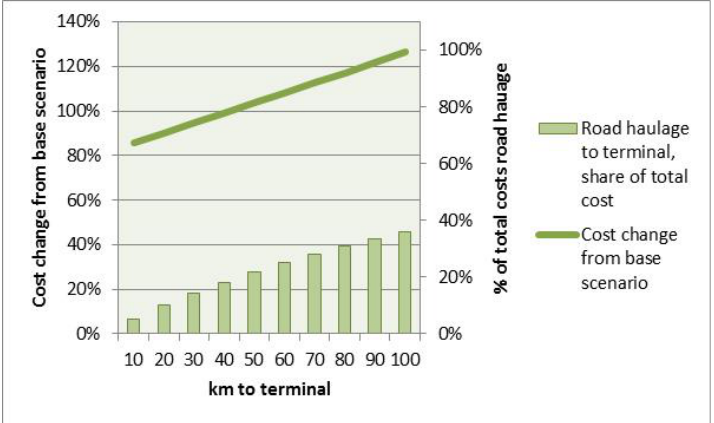
Figure 16. Effect of changed road distance to terminal with intermodal transhipment for the base scenario. Similar results are found for the 40m 3 system with an increased number of wagons, at a 1% cost increase. See Figure 17. In this case, the road transport costs are mainly unchanged, while the terminal costs are further increased due to the increased number of load units.